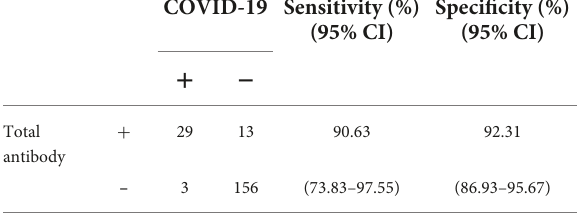
TABLE 4 Disease spectrum in unspecific reactivity with a total antibody titer ≥ 13.87 cut-off index (COI). Disease No (%) Antibody titer